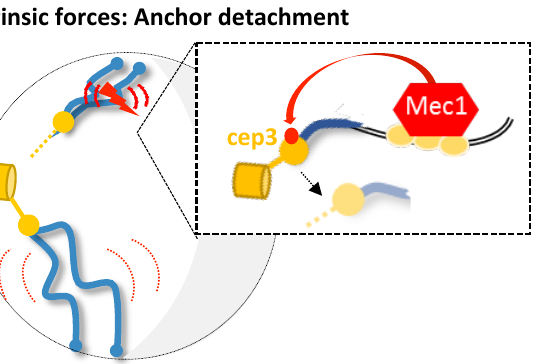
Figure 2. Representation for the various mechanisms proposed to increase chromosomal mobility upon DNA damage in budding yeast. Under damaged conditions (DSB is represented by the red flash), three possible scenarios of enhanced chromatin mobility are shown (global mobility is symbolized by large red curves and local by short red curves). First, the proposed mechanisms for global and local mobility include chromatin stiffening mediated either by H2A phosphorylation or Rad51 nucleofilament formation (as proposed in [10,13], respectively). A second model proposes chromatin remodeling as the mechanism underlying enhanced local and global chromatin mobility. Checkpoint signaling triggers INO80-C-dependent histone loss, thus leading to subsequent chromatin decompaction (represented by thinner chromosomes) [9,12,90]. Finally, in Strecker et al., 2016, it was proposed that Mec1 activation leads to the phosphorylation of the kinetochore protein Cep3. Thus, Cep3 phosphorylation would modulate the kinetochore/centromere attachments and lead to increased global and local dynamics. Drawing inspired from